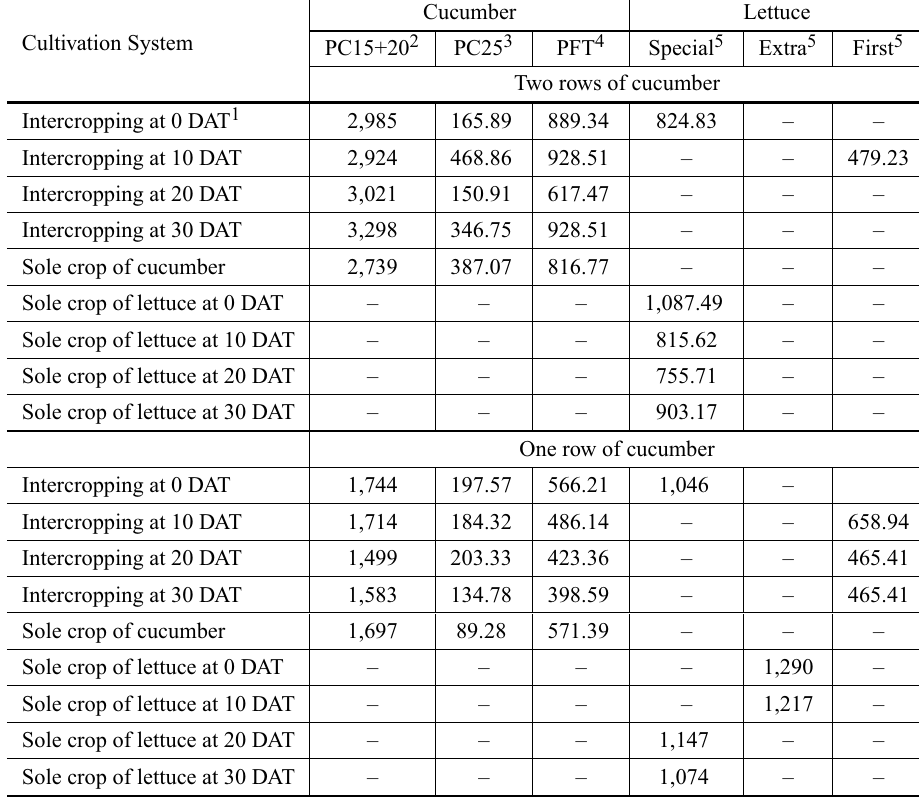
Crop yield (kg in 614.4 m 2 ) of lettuce ‘Verônica’ and Japanese cucumber ‘Hokushin’ cultivated in two and one row on the bed in intercropping and sole crop. Jaboticabal, SP, Brazil, 2007. Cucumber Lettuce Cultivation System PC15+20 2 PC25 3 Two rows of cucumber Intercropping at 0 DAT 1 2,985 Intercropping at 10 DAT 2,924 Intercropping at 20 DAT Intercropping at 30 DAT Sole crop of cucumber Sole crop of lettuce at 0 DAT Sole crop of lettuce at 10 DAT Sole crop of lettuce at 20 DAT Sole crop of lettuce at 30 DAT One row of cucumber Intercropping at 0 DAT Intercropping at 10 DAT Intercropping at 20 DAT Intercropping at 30 DAT Sole crop of cucumber 1,697 Sole crop of lettuce at 0 DAT Sole crop of lettuce at 10 DAT Sole crop of lettuce at 20 DAT Sole crop of lettuce at 30 DAT – –